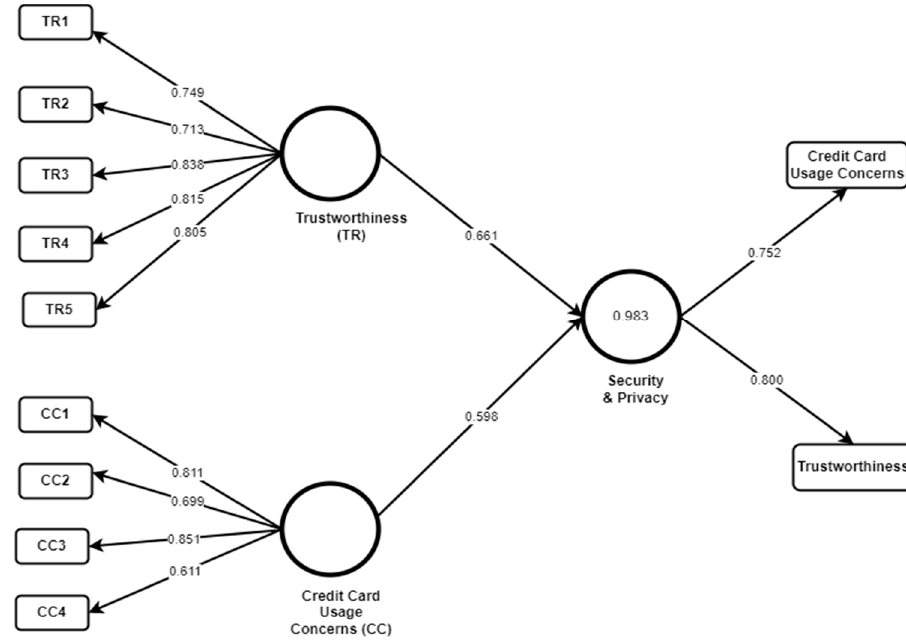
Figure 2. Amazon KSA Model 2.